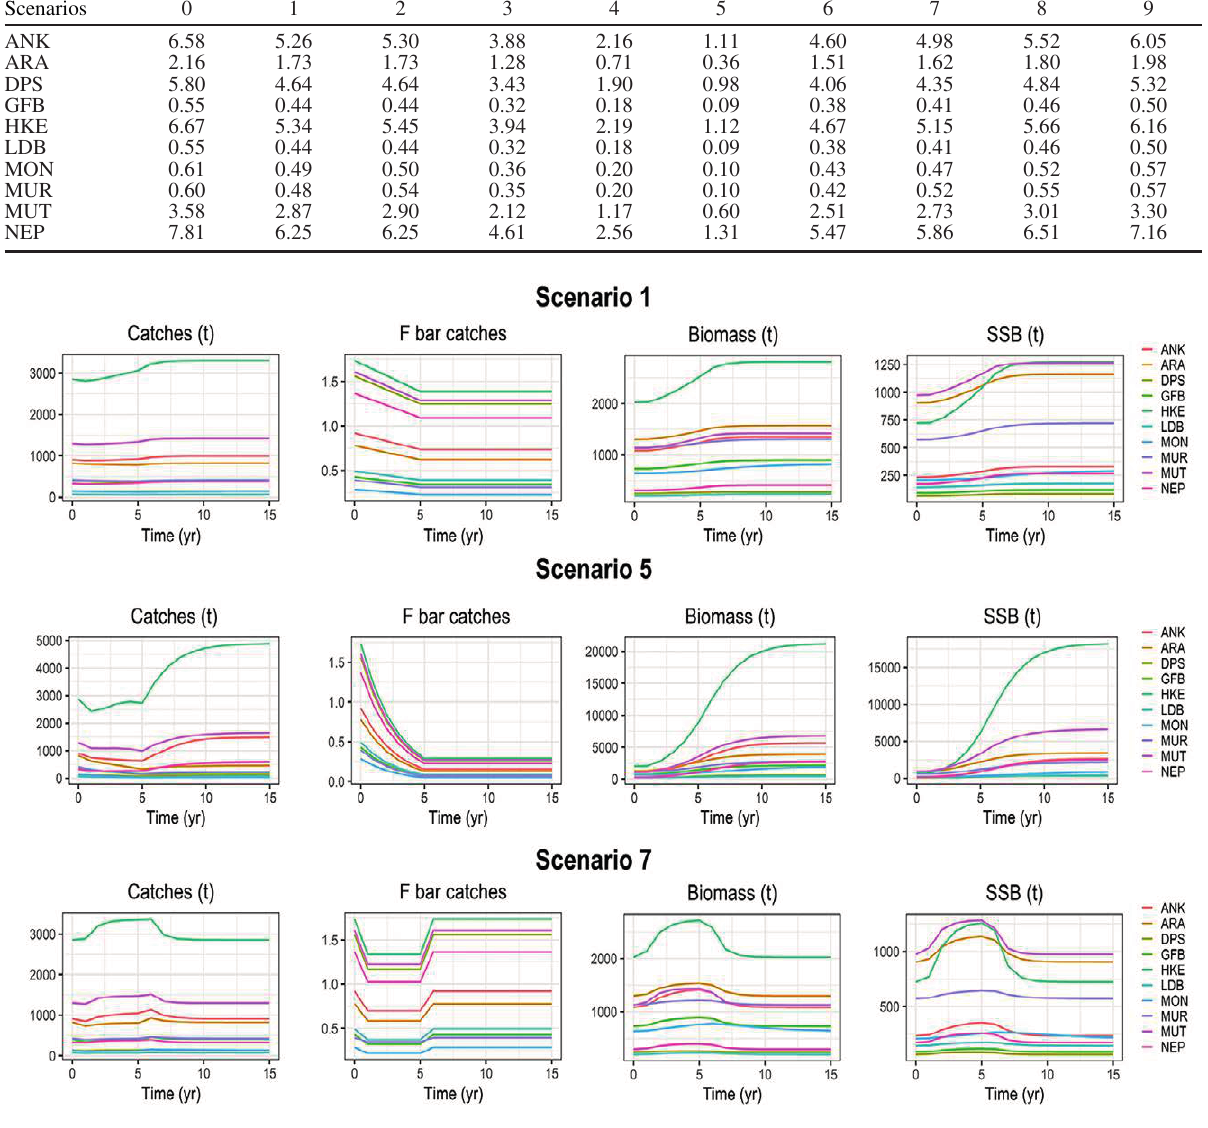
Fig. 2. – Catches, F , biomass and spawning stock biomass (SSB) trend over 15 years of simulation under the implementation of scenarios bar 1 (20% reduction of fishing days by the end of five years of simulation applied to all fleets), 5 (30% annual reduction of fishing days during five years of simulation applied to all fleets) and 7 (three-month closure applied to otter bottom trawl,